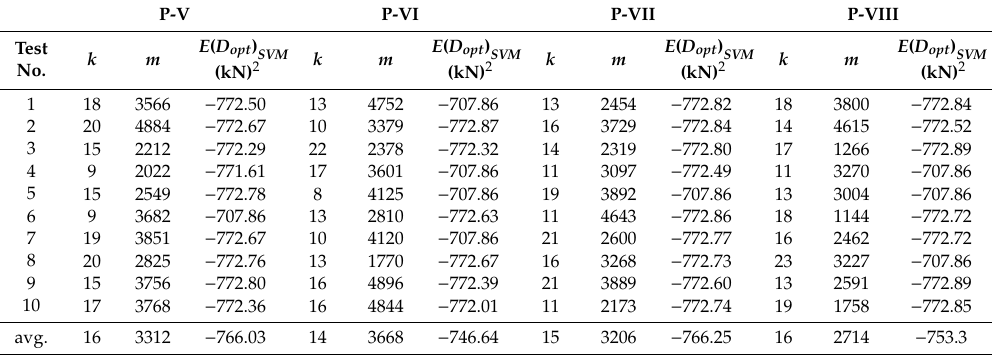
Table 7. The values of the optimal objective function with algorithms run by di ff erent adjustments. P-V P-VI P-VII P-VIII Test No.